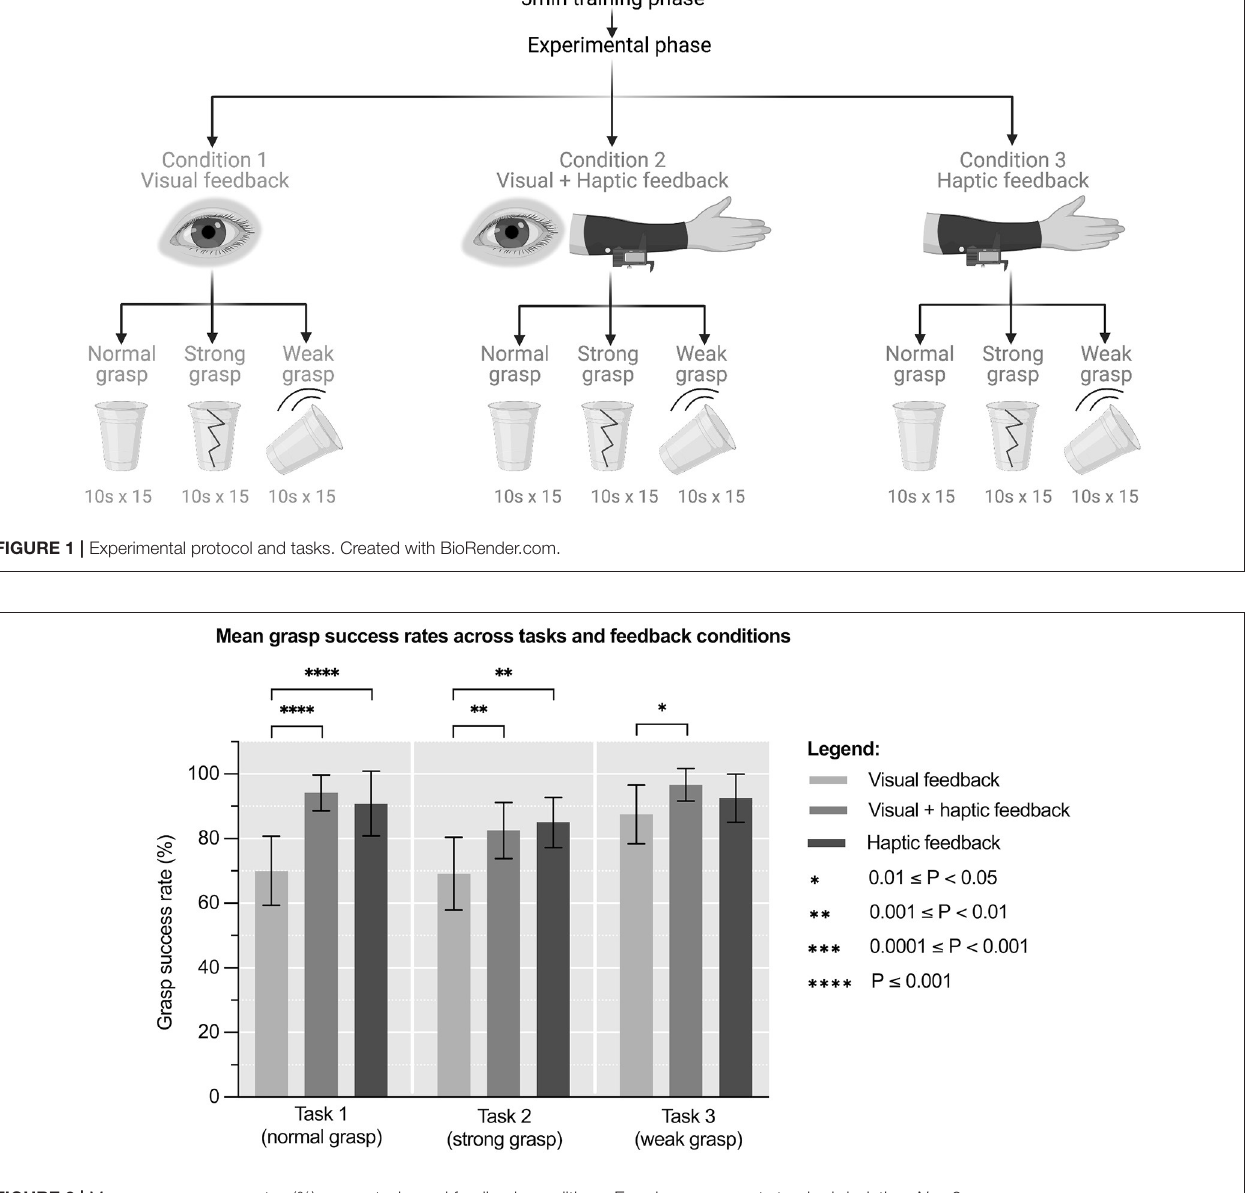
FIGURE 2 | Mean grasp success rates (%) across tasks and feedback conditions. Error bars represent standard deviation. N =